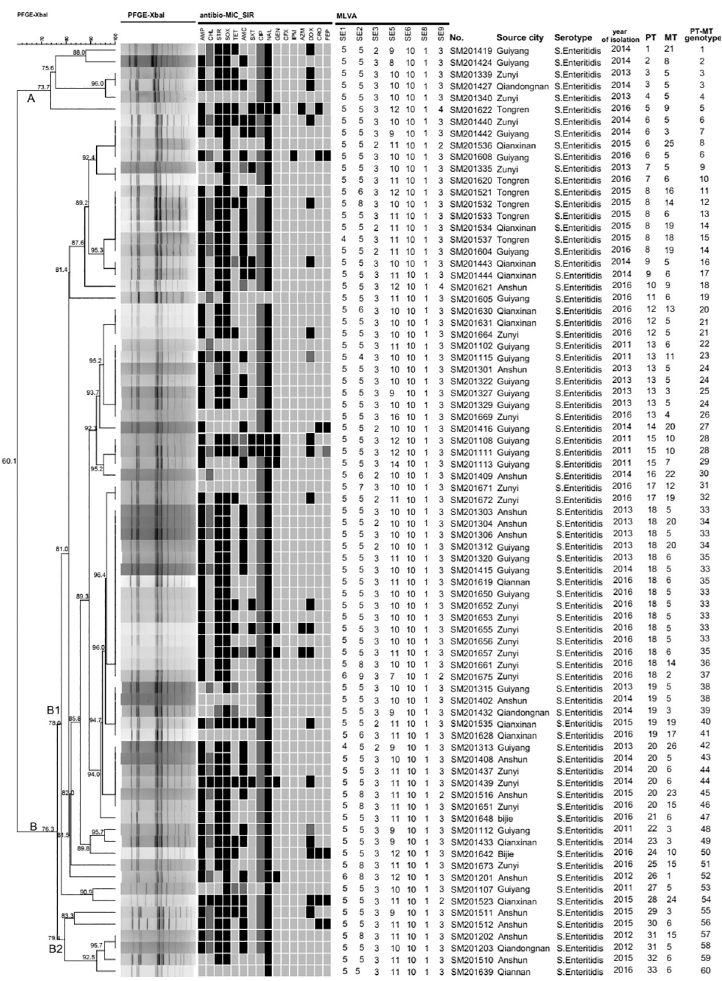
Fig 2. Pulsed-field gel electrophoresis (PFGE) pulsotypes based on Xba I enzyme digestion, antimicrobial resistance and multiple-locus variable-number tandem repeat analysis (MLVA) types of 79 S . Enteritidis isolates from Guizhou province. A black box represents resistance to an antimicrobial; a dark gray box represents intermediate to an antimicrobial; a light gray box represents susceptibility to an antimicrobial. MLVA types based on seven loci were shown on the right of AMR. The dendrogram was generated by UPGMA. The corresponding background information, pulsotype (PT), MLVA type (MT) and PT-MT genotype were shown on the right of